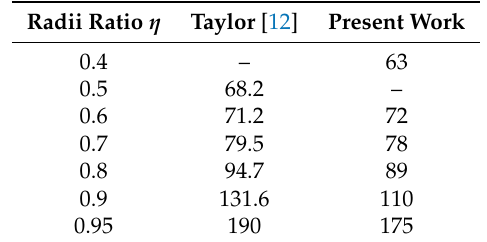
Table 1. Critical Reynolds number for the onset of instabilities for the case of constant angular speed. Radii Ratio η Taylor [12]